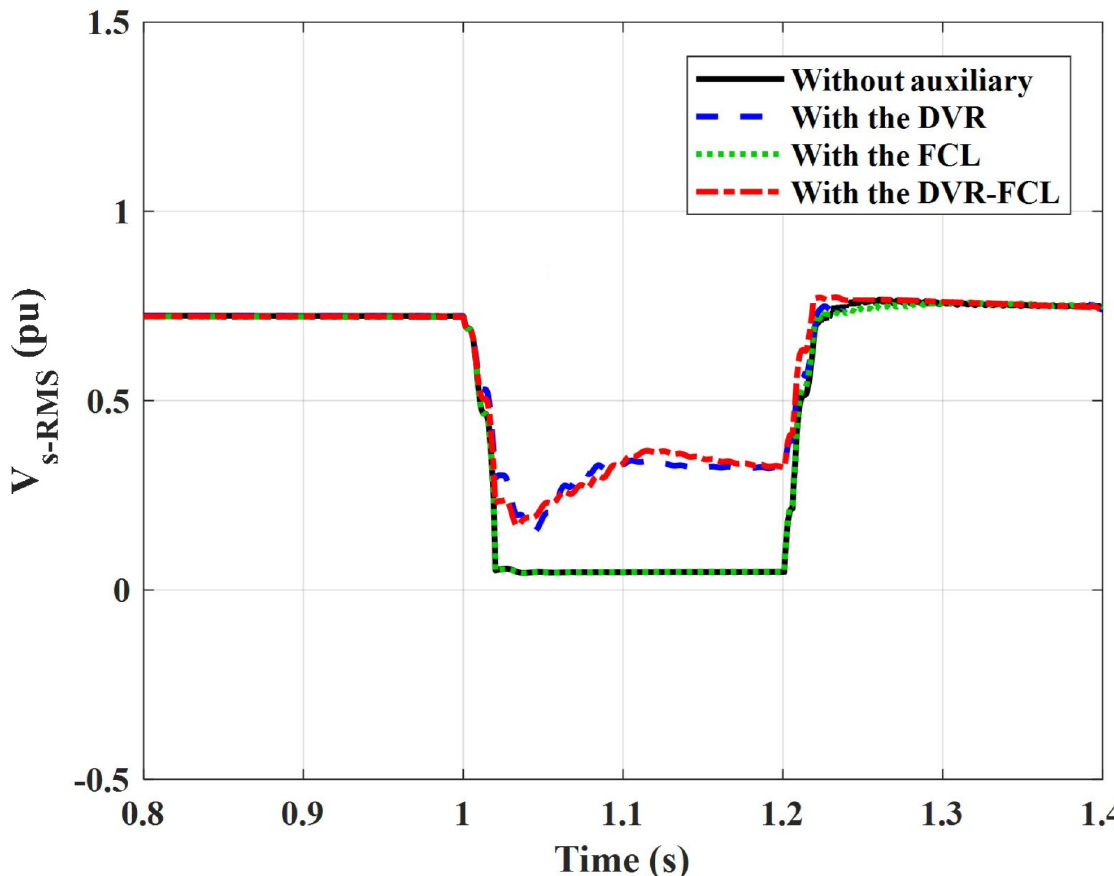
Fig 9. RMS value of the DFIG terminal voltage subject to the symmetrical